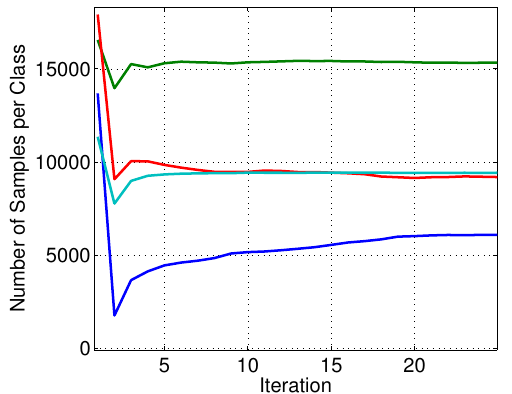
Figure 5: Convergence characteristics showing the number of samples per class (class is colour coded) for 25 steps of